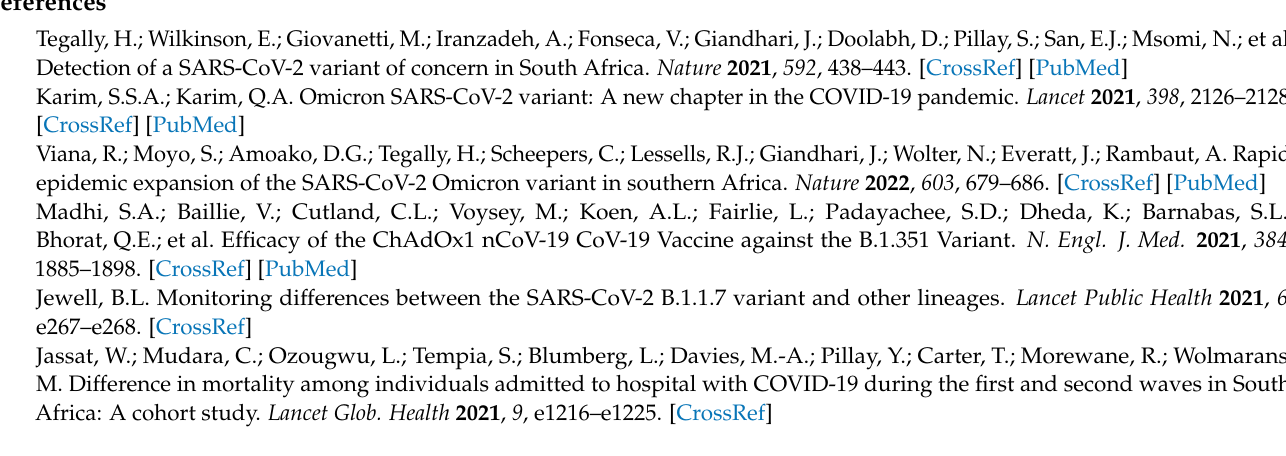
Figure S4: ViralVar Potential in Identifying Novel Variants in Small and Local Cohorts; Table S1: List of GISAID SARS-CoV-2 genome sequence IDs used in this paper; Table S2. Significant over and under-mutated SARS-CoV-2